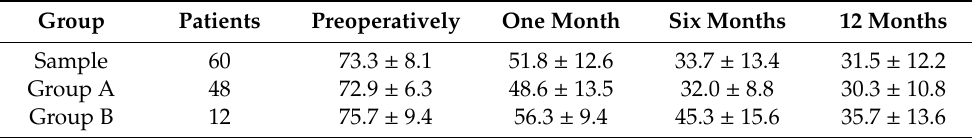
Table 3. PRTEE-I score results at preoperatively, one, six, and 12 months after the treatment.